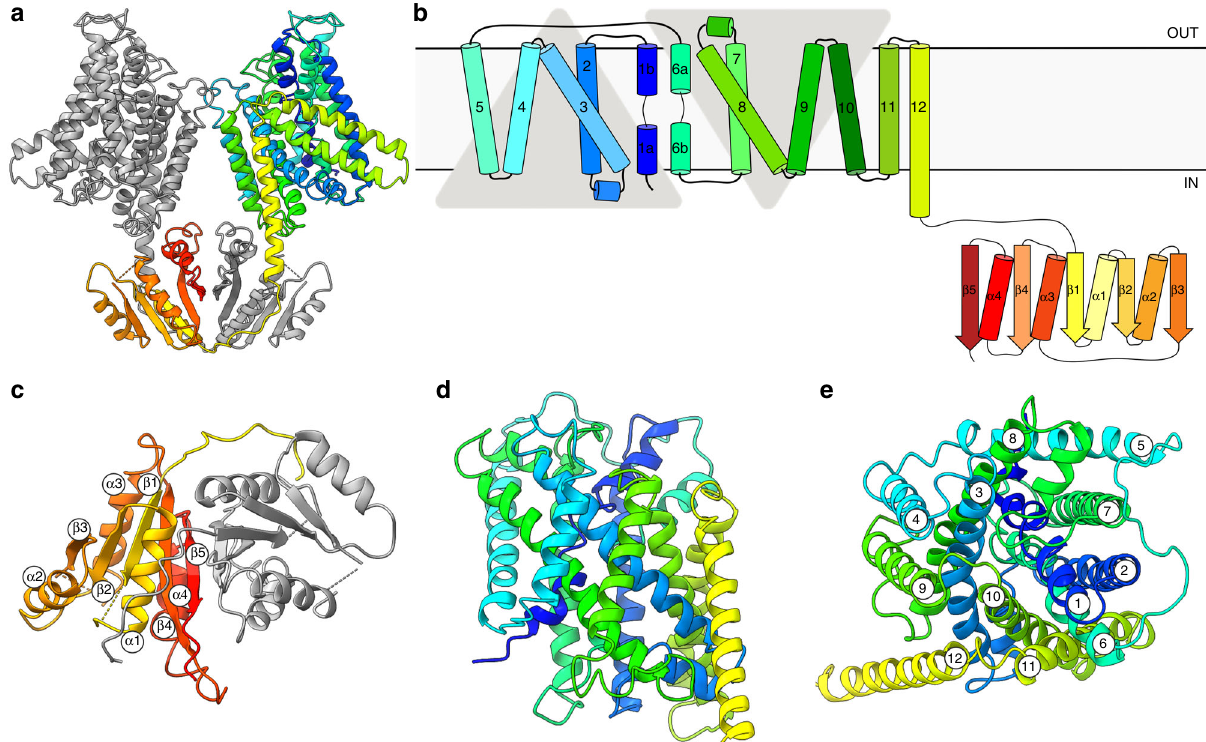
Fig. 2 Overview of the structure of KimA. a KimA dimer viewed from the membrane, with one monomer coloured in grey and the other in a rainbow, from blue (N terminus) to red (C terminus). b Schematic representation of the topology of KimA. Each KimA monomer is composed of 12 TM helices, organized in a 5 + 5 inverted structural repeat and two additional, C-terminal TM helices located at the periphery of the dimer. The last TM helix extends into the cytoplasm and positions the soluble domain below the TM domain of the second monomer. c The cytoplasmic domain of a KimA monomer is formed by a parallel, fi ve-stranded β -sheet sandwiched by four α -helices, forming a continuous 10-stranded β -sheet in the dimer. d Side view and e top view of the membrane domain of a KimA